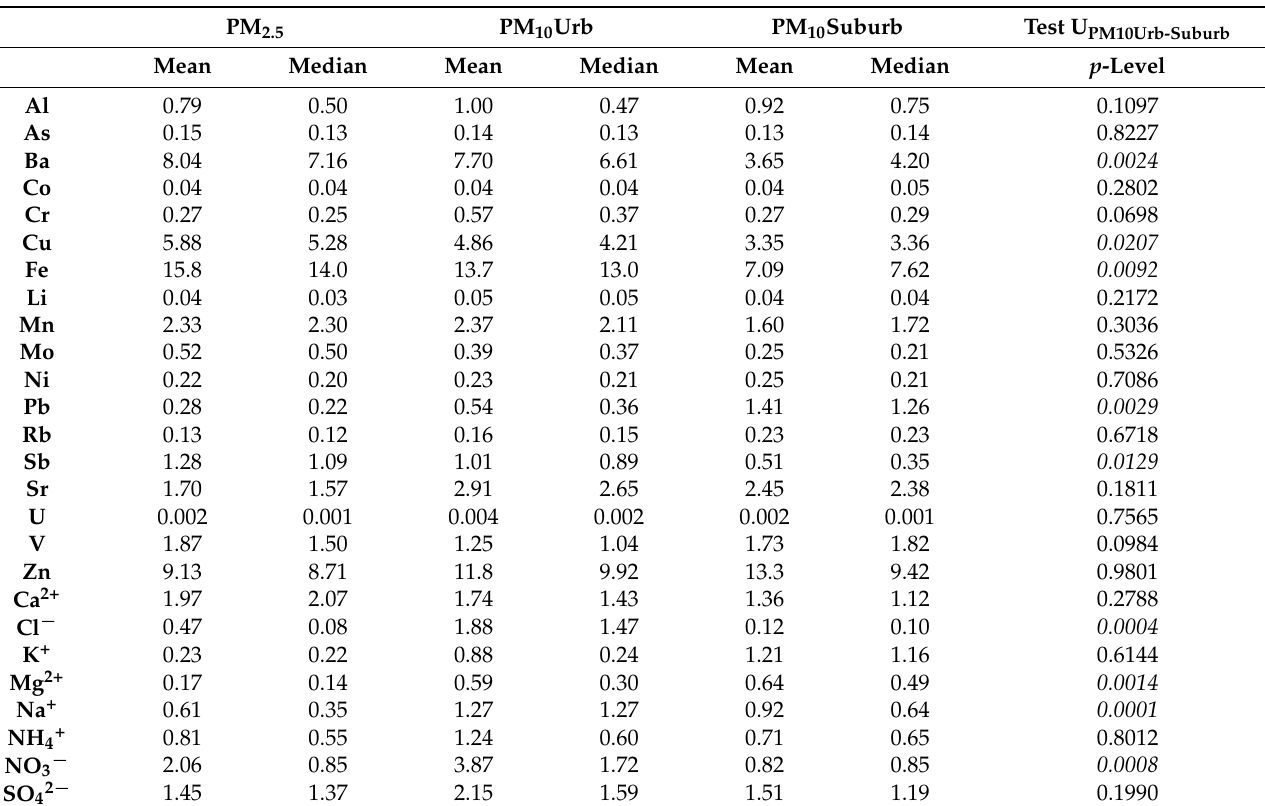
Table 3. Concentrations of water-soluble trace elements (WSTE) and the major ions in PM 2.5 and PM 10 samples. Data are expressed in ng m − 3 for trace elements and µ g m − 3 for major-ions. Test U: Mann–Whitney test ( p < 0.05). The level of statistical significance is indicated in